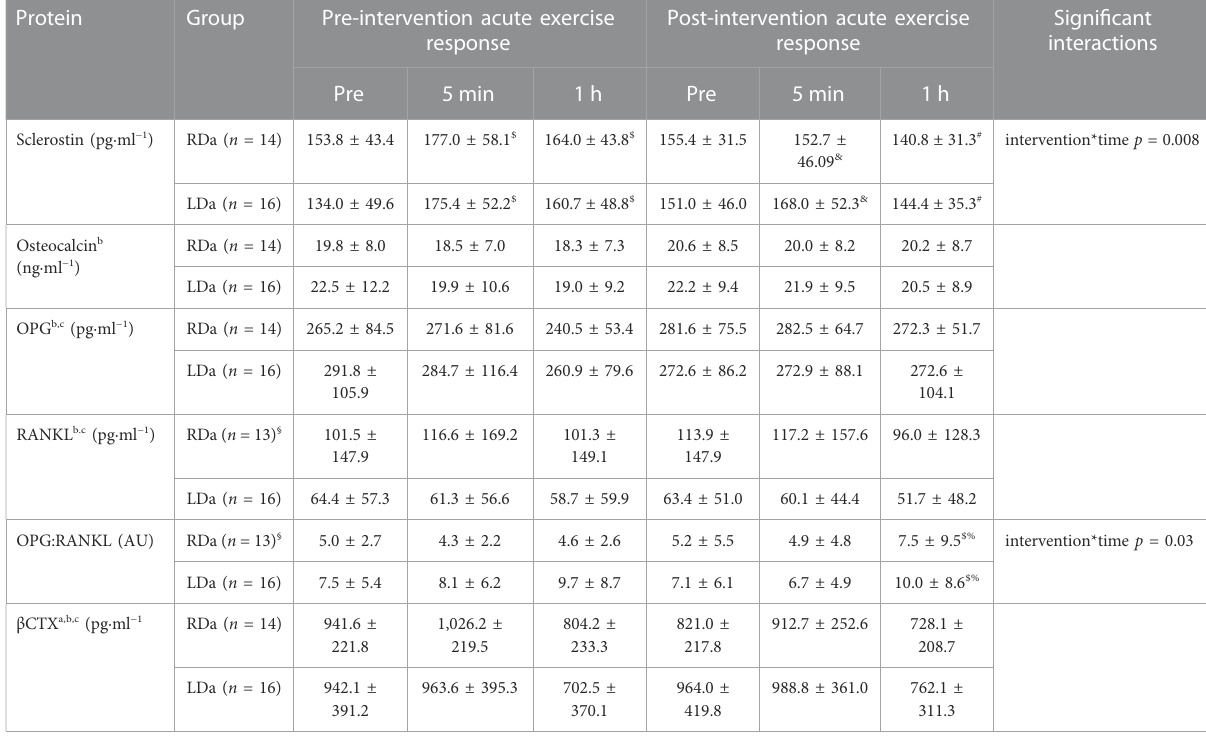
TABLE 2 Serum concentrations of bone biochemical markers and osteokines at rest (pre-exercise) and in response to acute plyometric exercise at pre- and post-intervention in the higher dairy intake (RDa) and the low dairy intake (LDa) groups. Protein Group Pre-intervention acute exercise Post-intervention acute exercise Signi fi cant response response